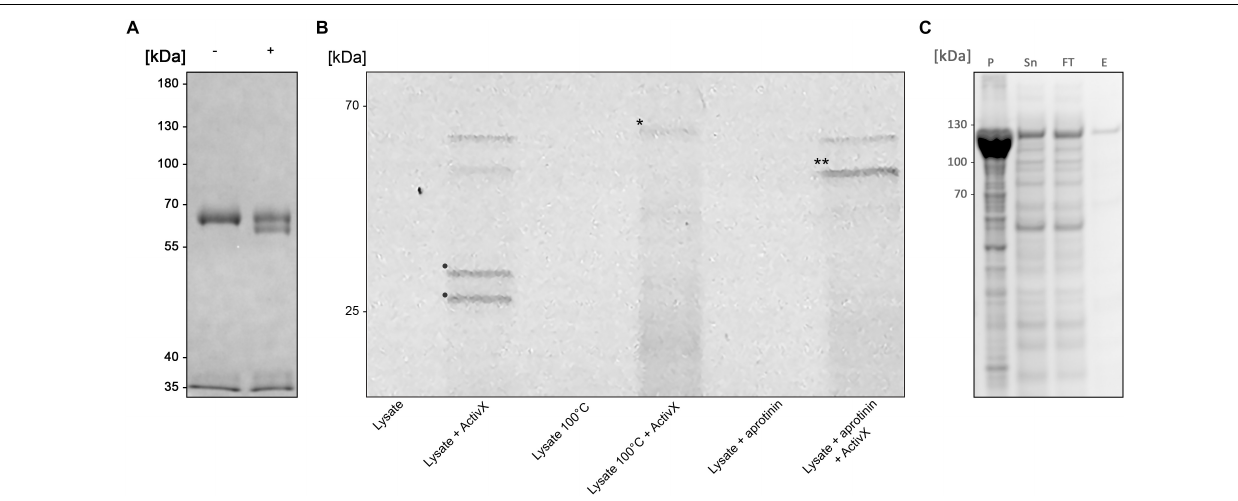
FIGURE 1 | BspE from Bdellovibrio bacteriovorus (A) SDS-PAGE showing the enzymatic activity observed with crude B. bacteriovorus lysate on human plasma IgA (pIgA). Minus (–) and plus (+) signs denote absence and presence of crude Bdellovibrio lysate in the sample, respectively. (B) SDS-PAGE identifying Bd2962 from crude B. bacteriovorus lysate with ActivX Serine Hydrolase Probe. The addition of aprotinin resulted in inhibition of, and thus the elimination of two potential protease candidates (bands denoted with • in the second lane, as compared to the last lane). Further, the insensitivity to heating left only one band of interest for further characterization (the disregarded band is denoted with ∗ in lane four). The final band of interest is denoted in the figure with ∗∗ . (C) Recombinant expression of BspE. The MBP-bd2906-His fusion protein is non-toxic and readily expressed in E . coli. The protein is partly found as inclusion bodies in the pellet (P) after cell lysis. Purification of the fusion protein from the supernatant (Sn) by Ni 2 + affinity column purification resulted in loss of some protein in the flow through (FT). The eluted purified protein (E) was of high purity > 95% (as determined by visual inspection).